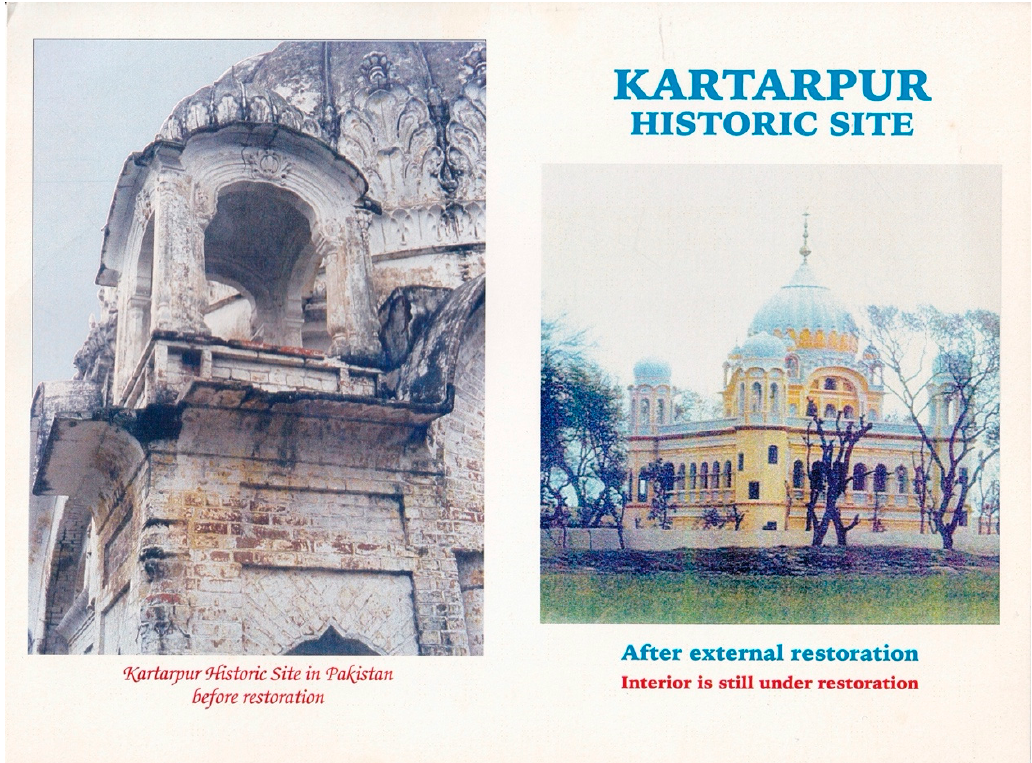
Figure 4. Side by side photos of Darbar Sahib, Kartarpur from 1992 (before restoration) and 1999 (post external restoration).